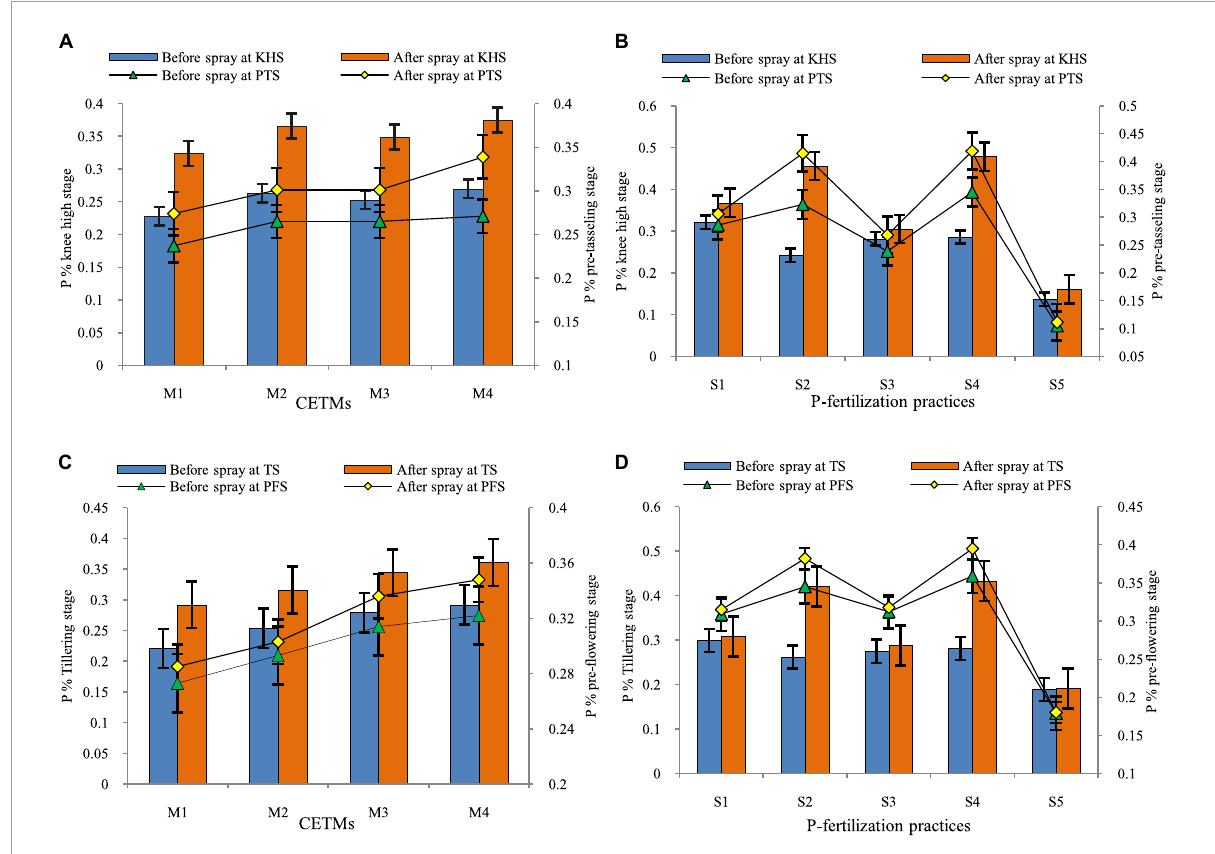
FIGURE6 Effect of crop establishment and tillage management (CETM) and P-fertilization practices on phosphorus content before and after spray at knee-high (KHS) and pre-tasseling stage (PTS) of maize (A,B) and at tillering stage (TS) and pre-flowering stage (PFS) of wheat (C,D) under MWCS (2-years’ av.). The vertical bars represent LSD 0 . 05 values. M 1 , flat bed–conventional tillage (FBCT) both in maize and wheat; M 2 , raised bed–CT (RBCT) in maize and RB–zero tillage (RBZT) in wheat; M 3 , FBZT both in maize and wheat; M 4 , permanent raised bed–ZT (PRBZT) both in maize and wheat. S 1 -P 100 , 100% P as basal; S 2 -P 50 + 2FSP, 50% P as basal (P 50 ) + 2 foliar sprays of phosphorus (2FSP) as DAP (2%) at knee-high stage (KHS) and pre-tasseling stage (PTS) in maize and at tillering stage (TS) and pre-flowering stage (PFS) in